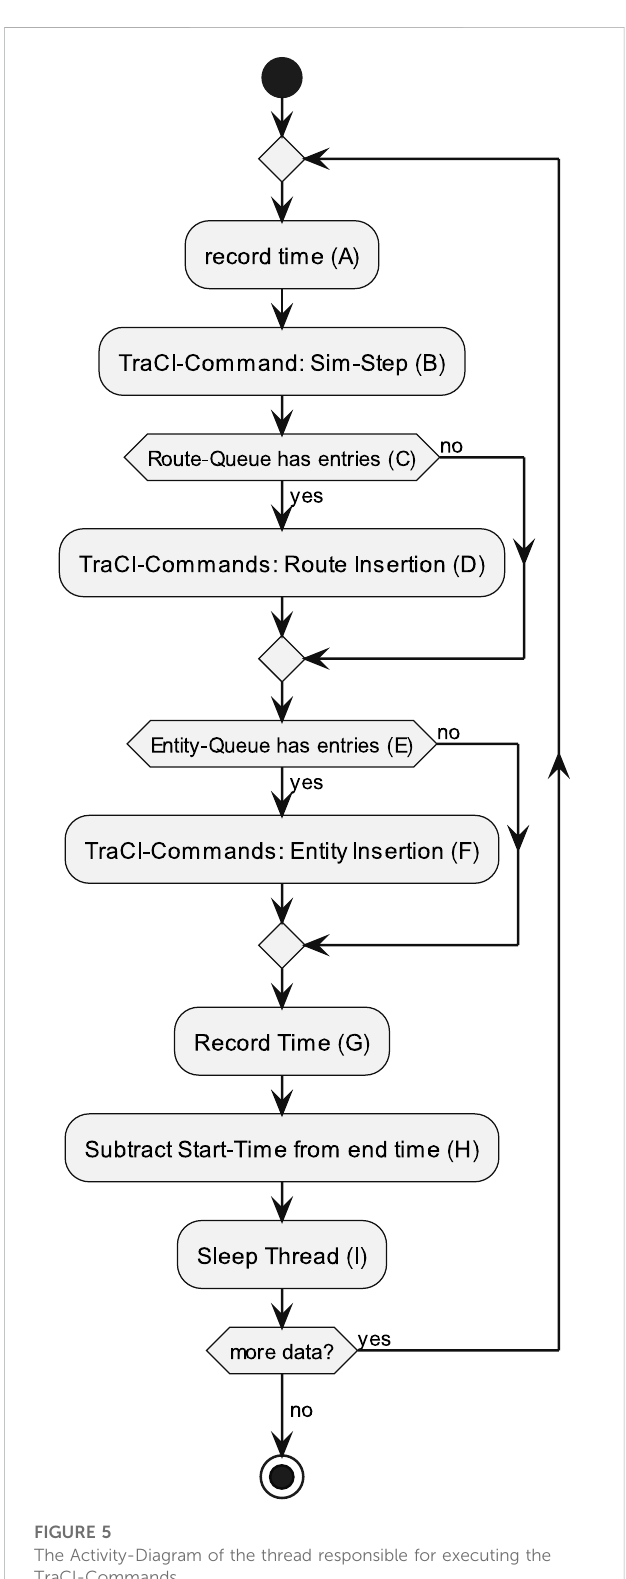
FIGURE 5 The Activity-Diagram of the thread responsible for executing the